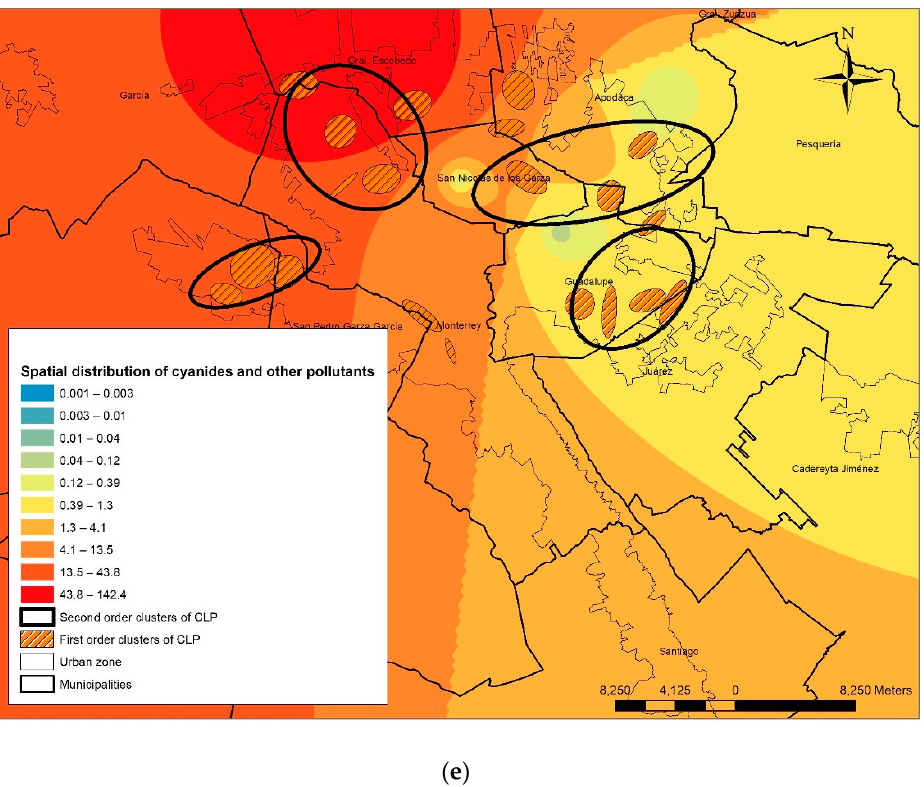
Figure 5. Spatial interpolation of industry´s pollutants. ( a ) Gases; ( b ) aromatic pollutants; ( c ) organic halogenated pollutants; ( d ) metals and metalloids; ( e ) cyanides and other